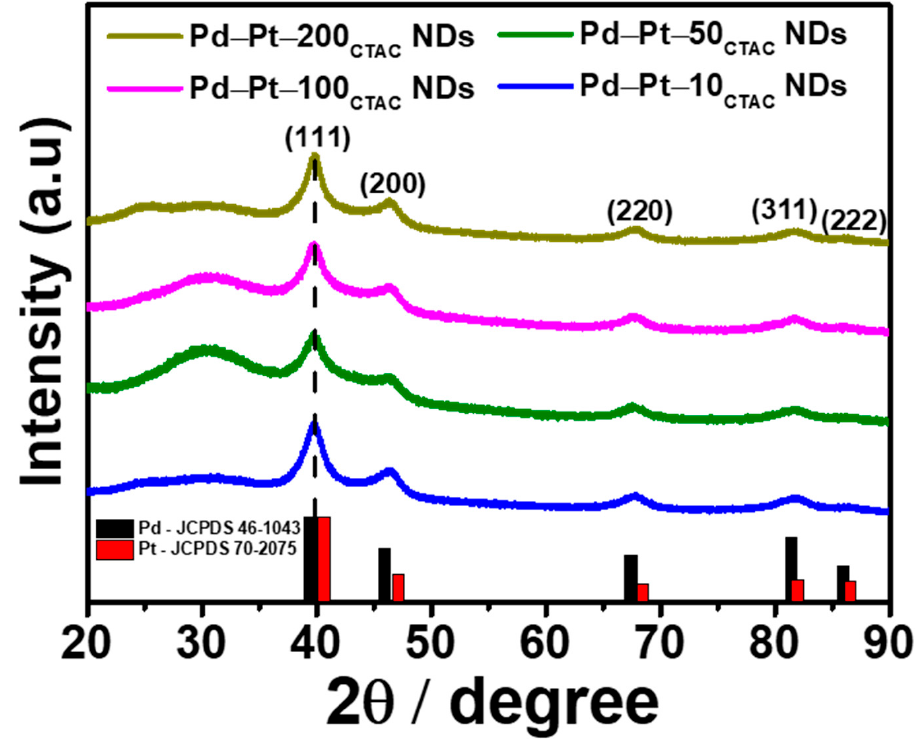
Figure 3. XRD pattern of Pd–Pt NDs with controlled CTAC concentrations. The line pattern shows reference cards 46-1043 and 70-2075 for Pd and Pt according to JCPDS.